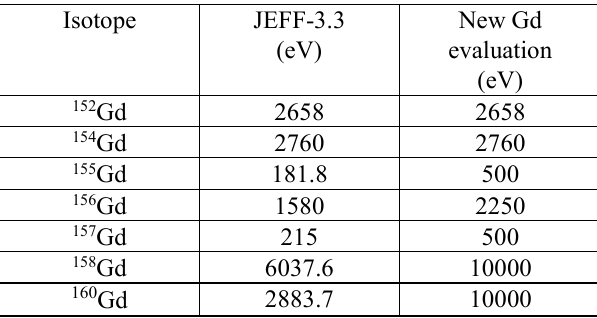
Table 1. Resonance region upper